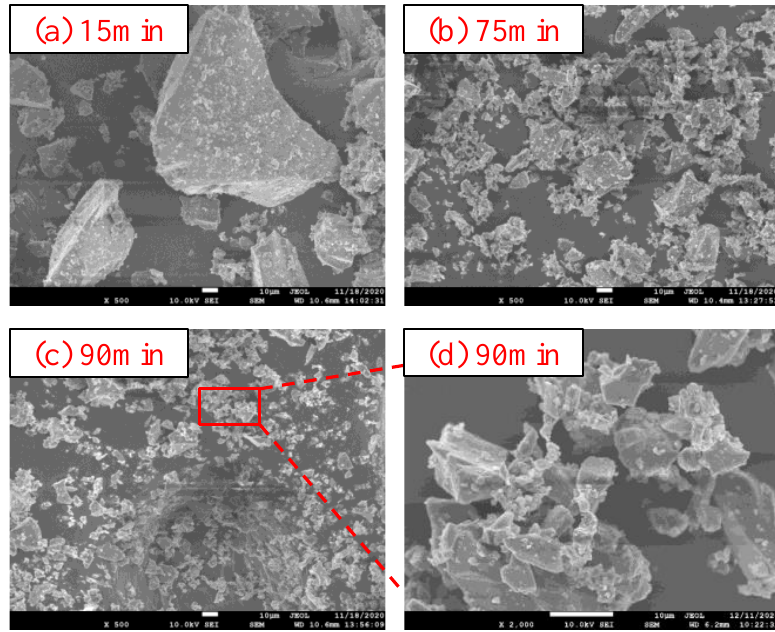
Figure 4. Microstructure characteristics of CGS with different grinding time.